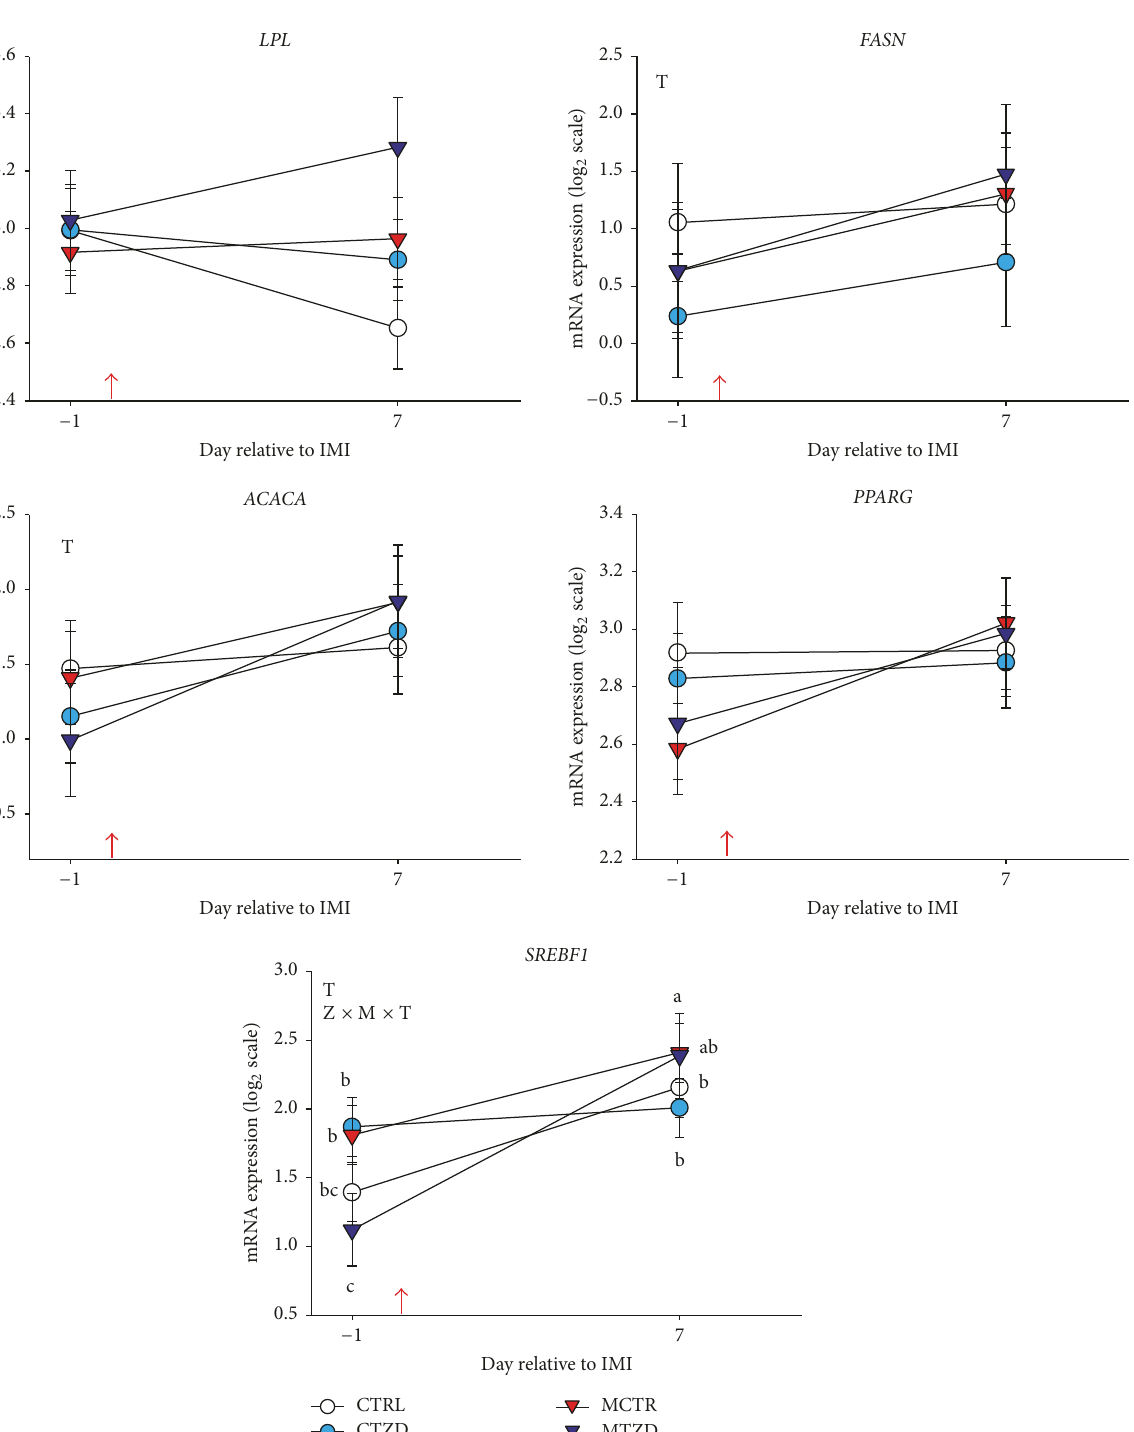
Figure 9: Transcript abundance of selected genes in subcutaneous adipose tissue in goats receiving intramammary infusion (IMI) of Strep. uberis (M) or saline plus daily intrajugular injection of 2,4-thiazolidinedione (TZD) or saline (CTR). Significant ( 𝑃 ≤ 0.05 ) effects and interactions are indicated in the graph (mastitis: M, time: T, and TZD: